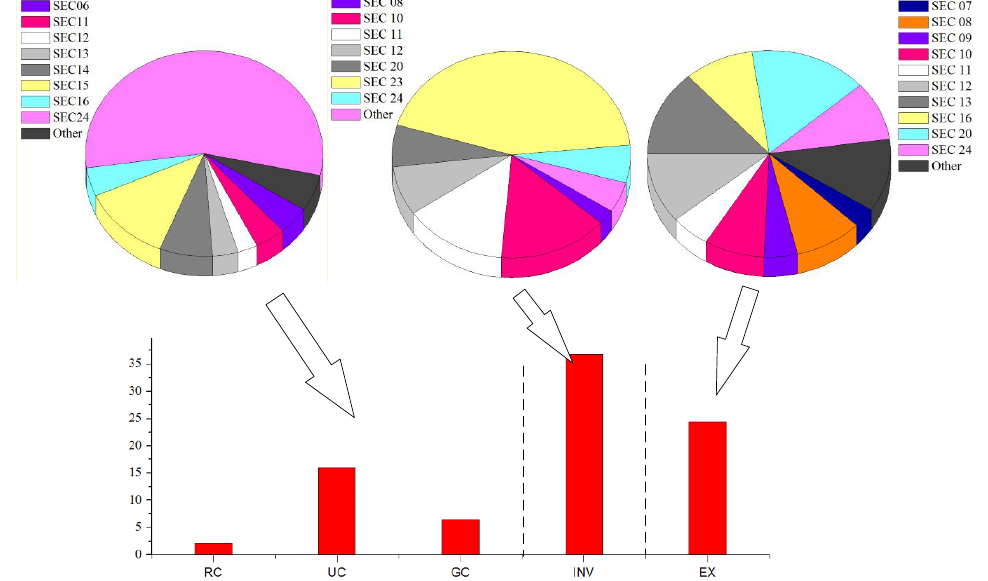
Figure 4. The contribution of different end uses on CO 2 emissions growth.